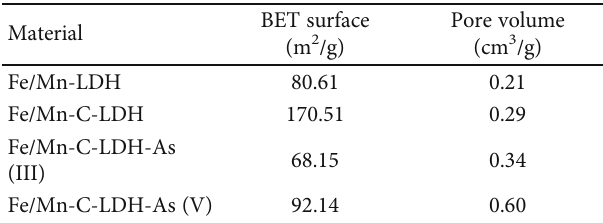
Table 2: BET surface and pore volume of Fe/Mn-LDH before and after